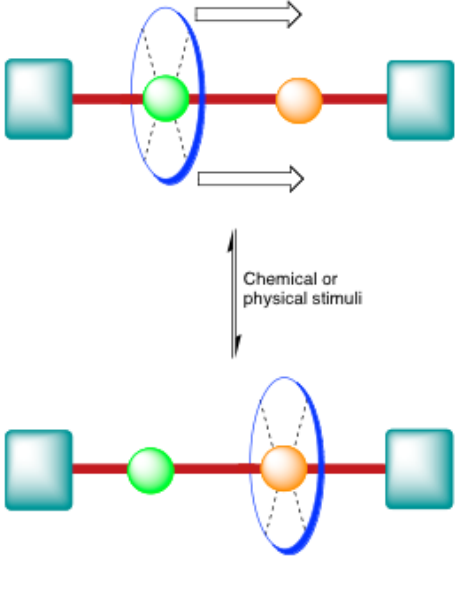
Figure 1. Cartoon representation of a translational motion allowed in a